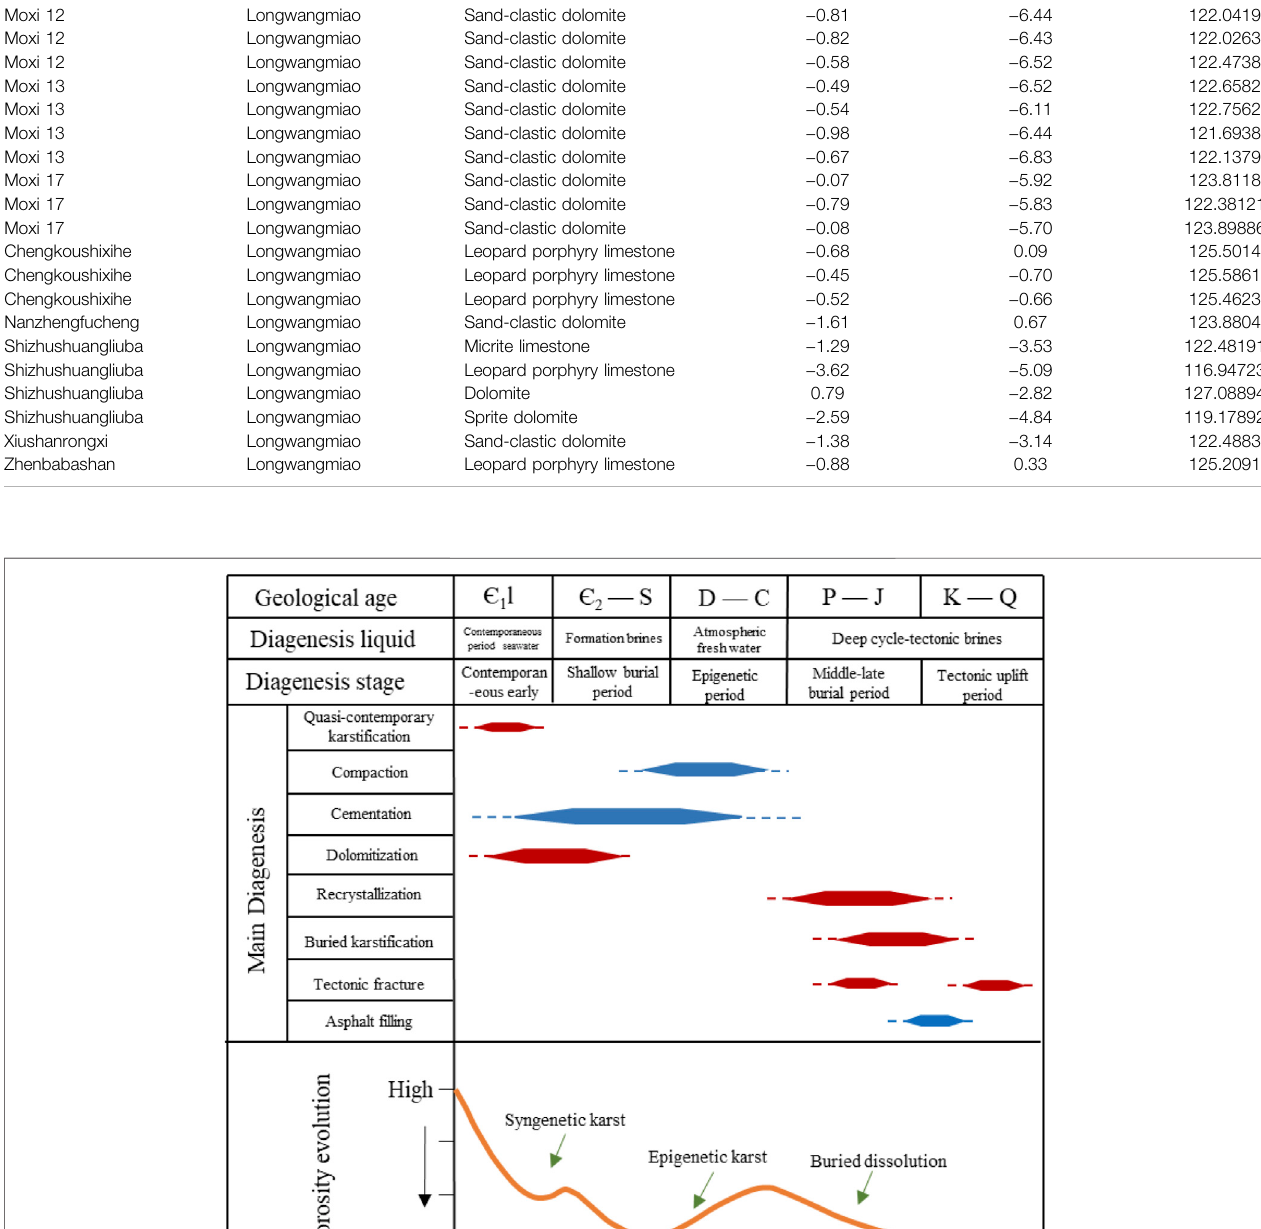
Frontiers in Earth Science |